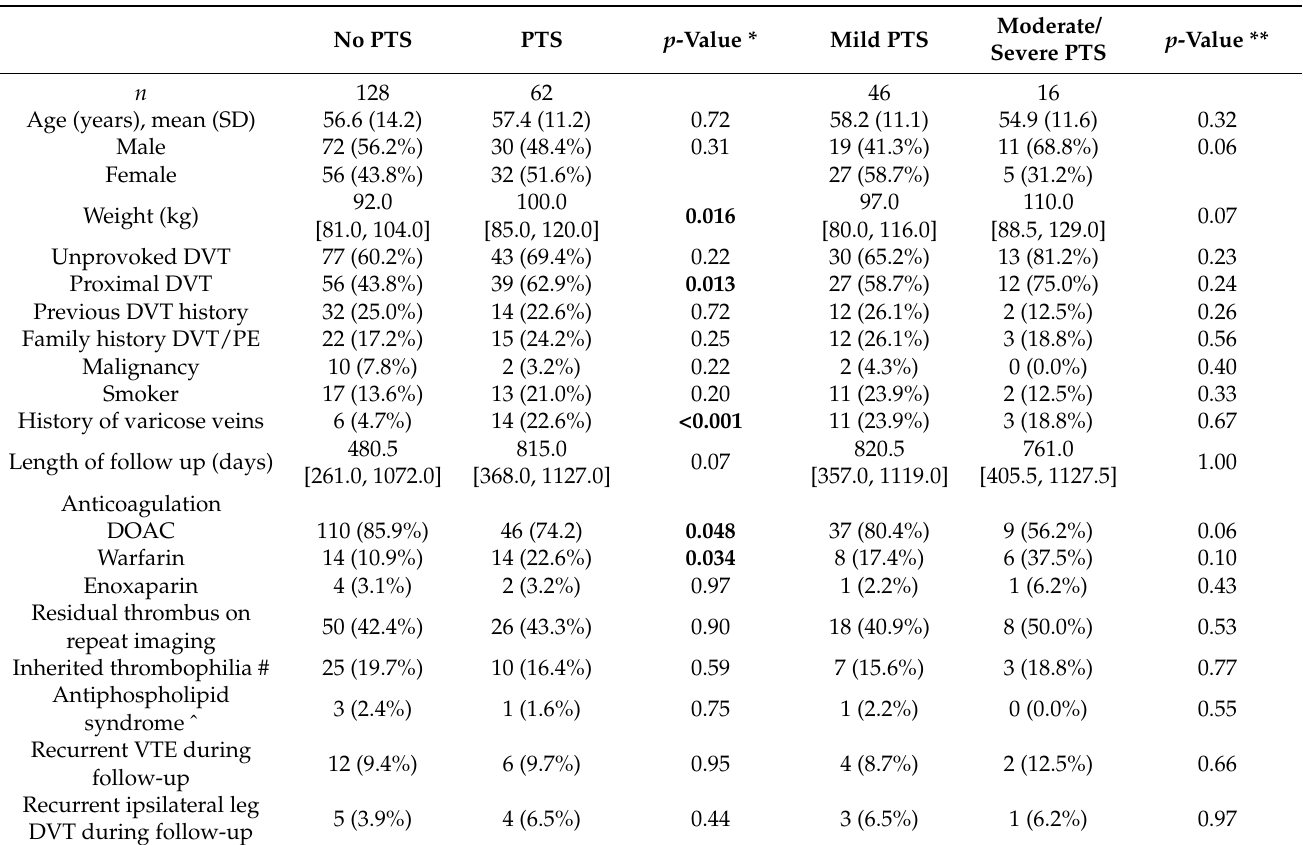
Table 1. Clinical characteristics of patients with and without post-thrombotic syndrome. Data are n (%), and median [interquartile range, IQR] unless specified